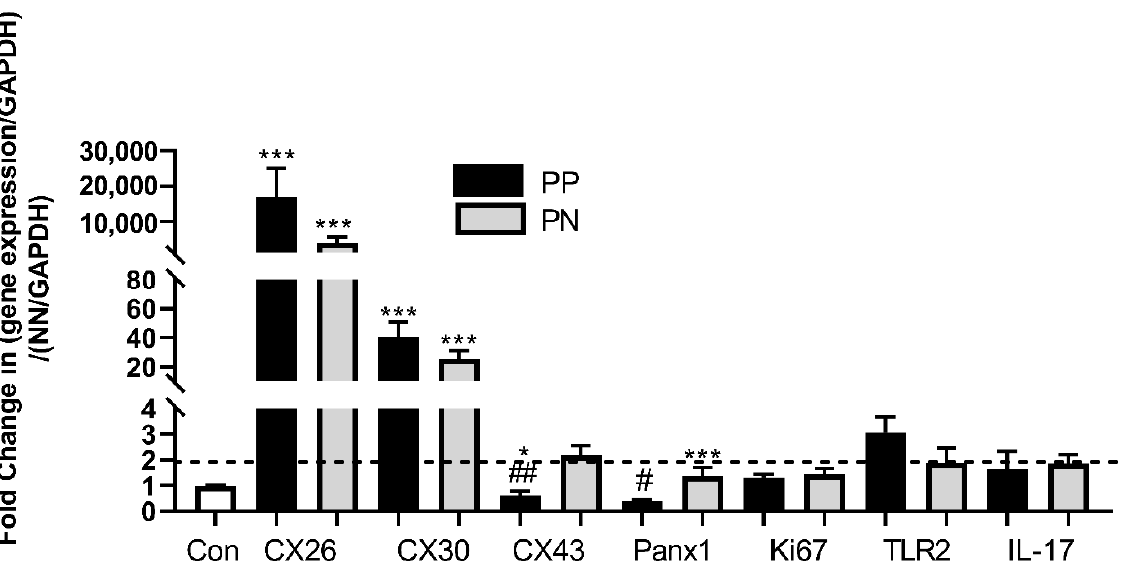
Figure 3. Gene expression profiles of NN, PN and PP biopsies. RNA was extracted from NN, PN and PP tissue biopsies and subject to RT-PCR analysis. Results are presented as the fold change in gene expression/GAPDH compared to NN gene expression/GAPDH. Data sets were statistically analysed by ANOVA followed by Dunnett’s multiple comparison test comparing PP and PN samples with control (***) and PN with PP samples (##). N = 6 biopsies per patient *** (###) p < 0.0001; ## p < 0.005; * (#) p < 0.01. The dotted line indicates a twofold increase in gene expression considered biologically significant [25].